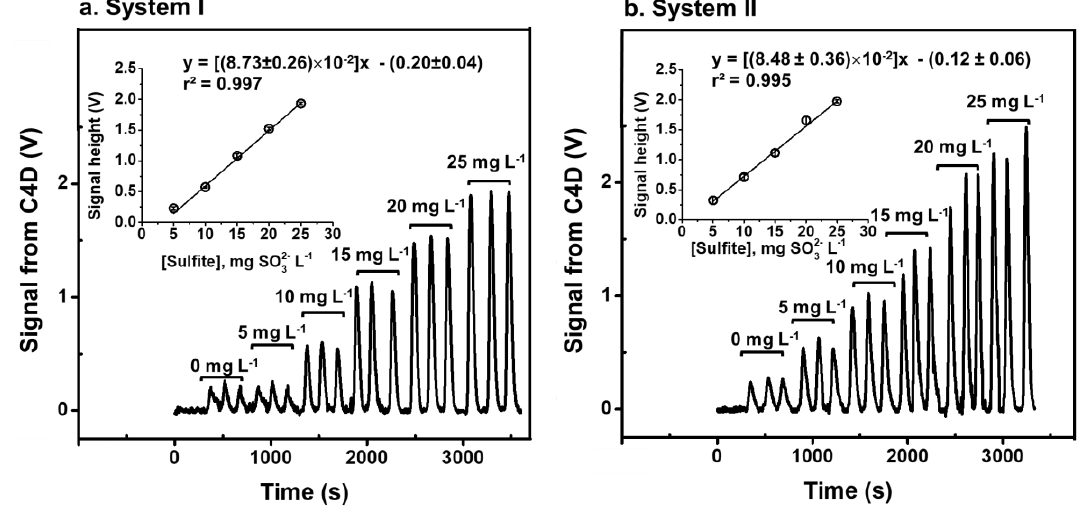
Figure 2. Signal profiles of standard sulfite solutions obtained from ( a ) System I and ( b ) System II. Insets are the linear calibration graphs after the subtraction of reagent blank signal (0 mg SO 32 − L − 1 ).